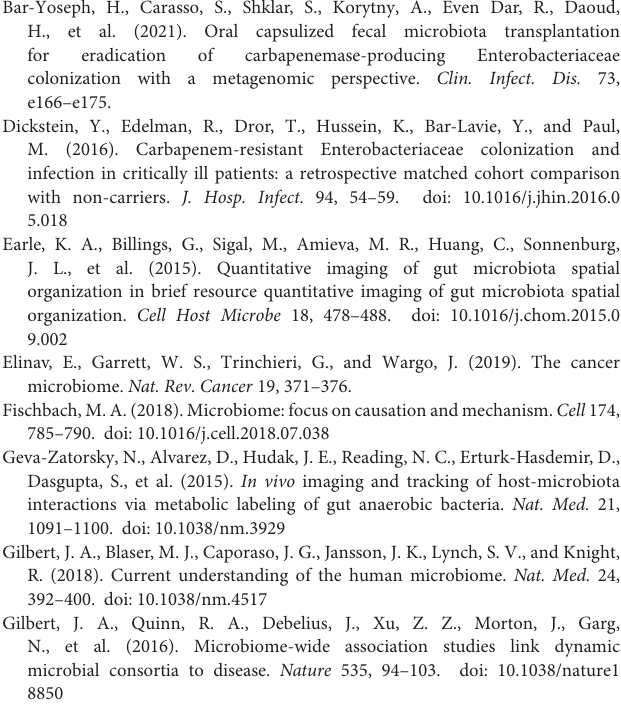
Hajjo, H., and Geva-Zatorsky, N. (2021). Strain-level immunomodulatory variation of gut bacteria. FEBS Lett. 595, 1322–1327. doi: